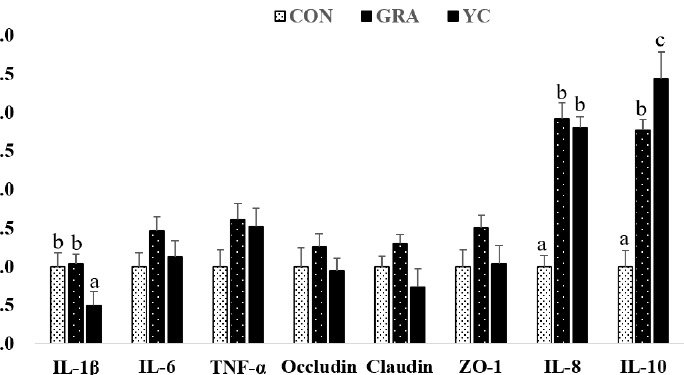
Figure 2. Effect of yeast culture supplementation on the mRNA levels of immunity-related genes in